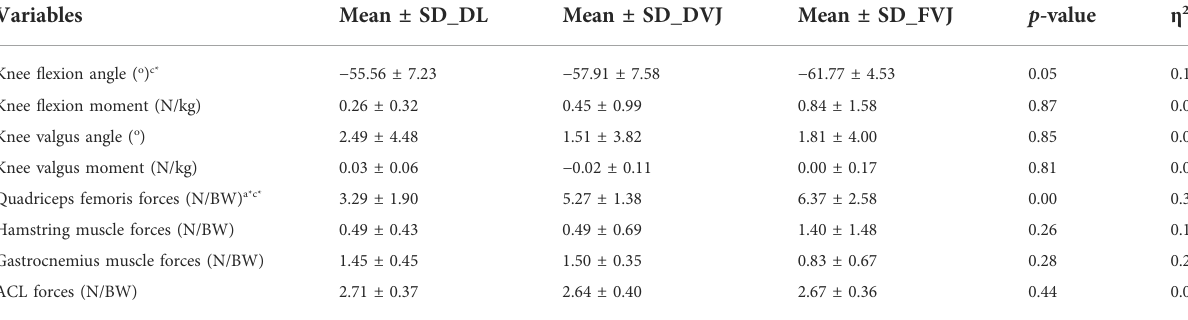
TABLE 1 Statistics of knee variables from the IC phase of three landing actions performed by 11